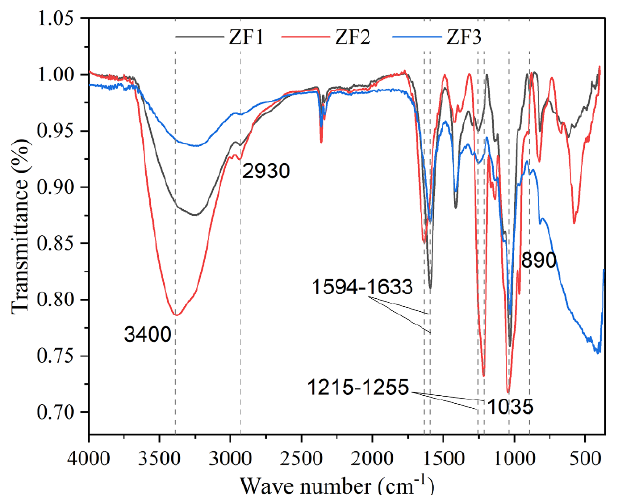
Figure 4. FTIR spectrum of ZF1, ZF2, and ZF3. The scanning range of FTIR spectrum is 4000–400 cm − 1